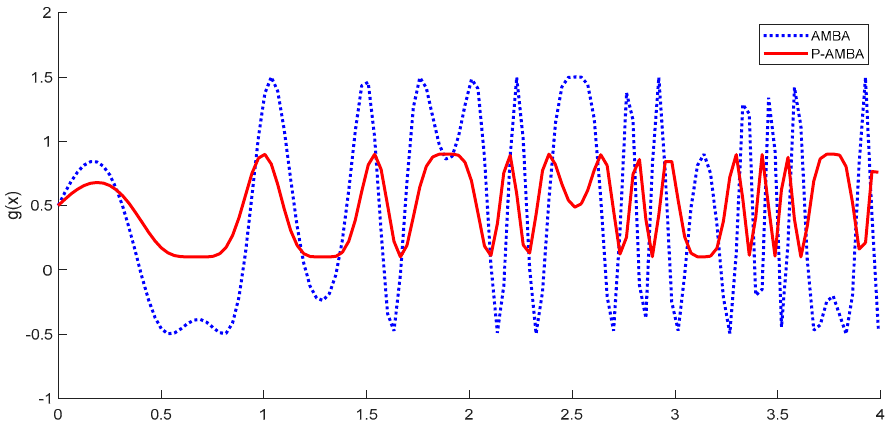
Figure 3. Generating function plotted with default values ( a = 0, b = 0.5, c = 0.8, d = 0.5, e = 0.4, and g = 0.2).